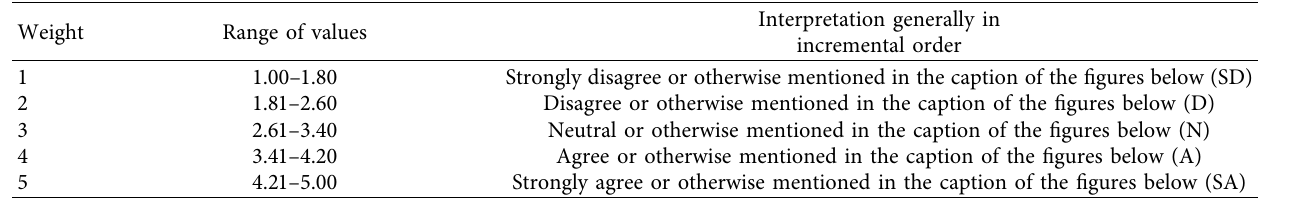
Table 2: Te range of values to be used to interpret the weighted values with 0.8 as the diference between the two values. Weight